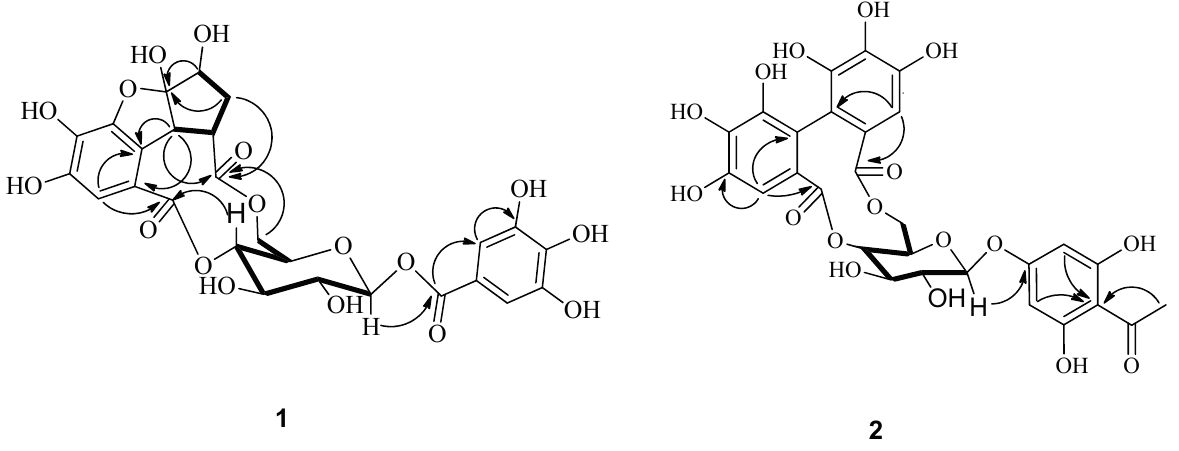
Figure 2. 1 H- 1 H COSY ( ▬ ) and key HMBC ( → ) correlations of compounds 1 and 2